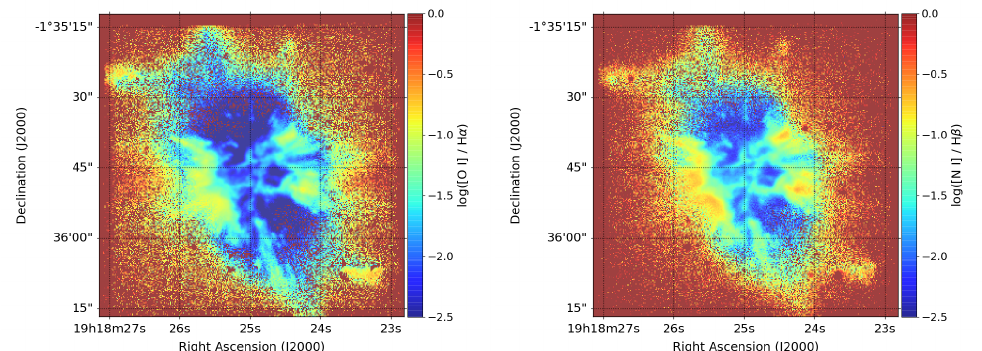
Figure 5. Emission line ratio maps of NGC 6778: [S II ] λ 6716 + λ 6731/H α ( upper left panel ), [O III ] λ 4959 + λ 5007/H β ( upper right panel ), [O I ] λ 6300/H α ( lower left panel ), and [N I ] λ 5200/H β ( lower right panel